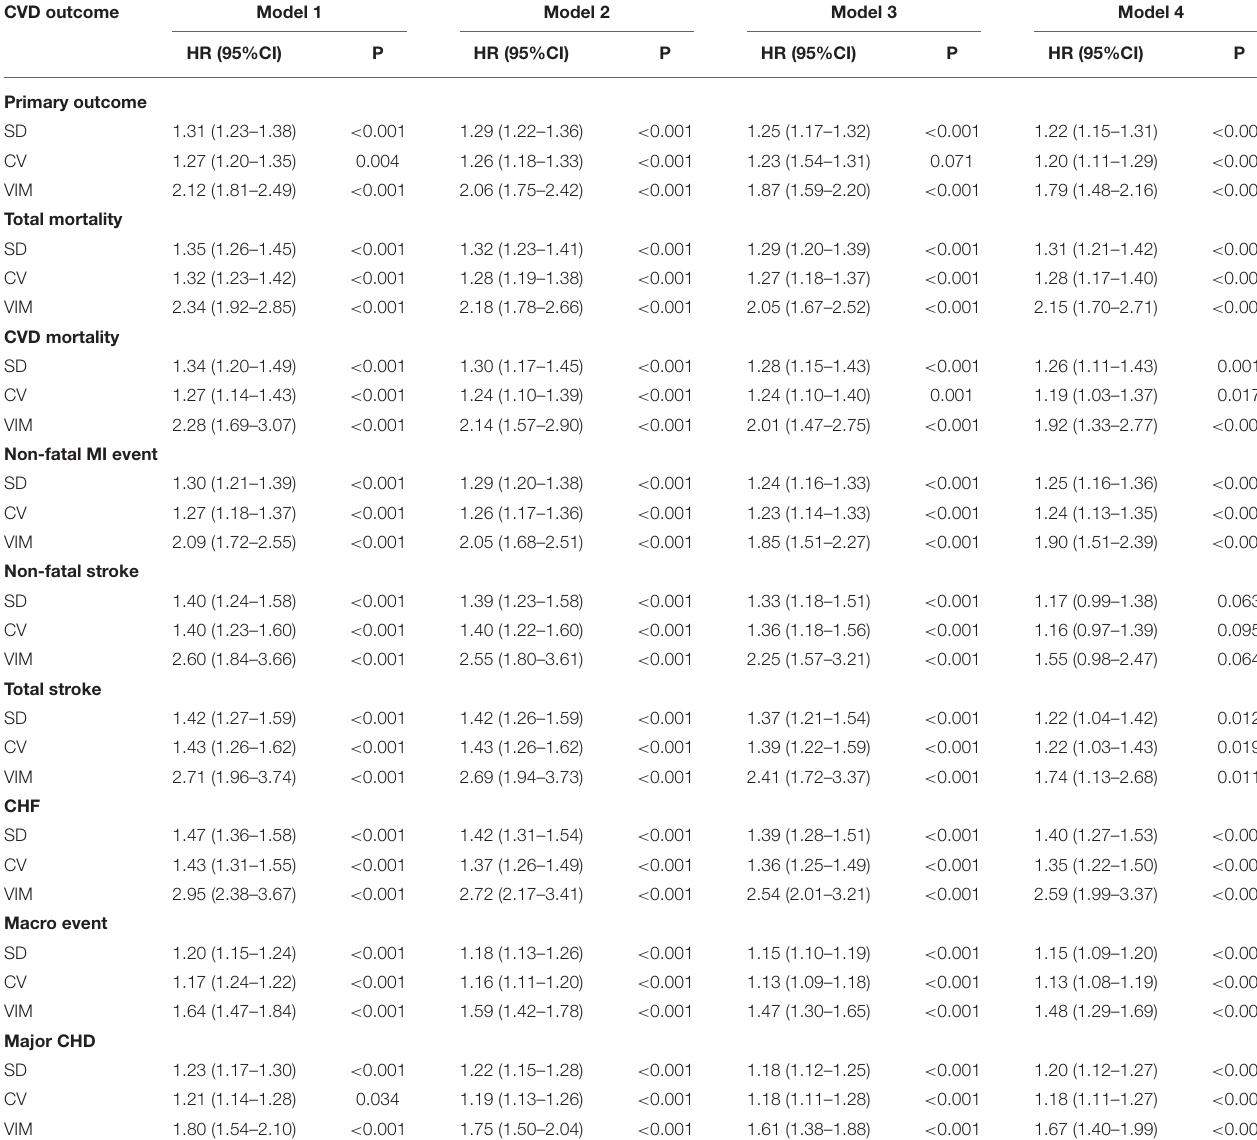
TABLE 2 | Visit-to-visit variability of HbA1Cas a continuous variable and cardiovascular